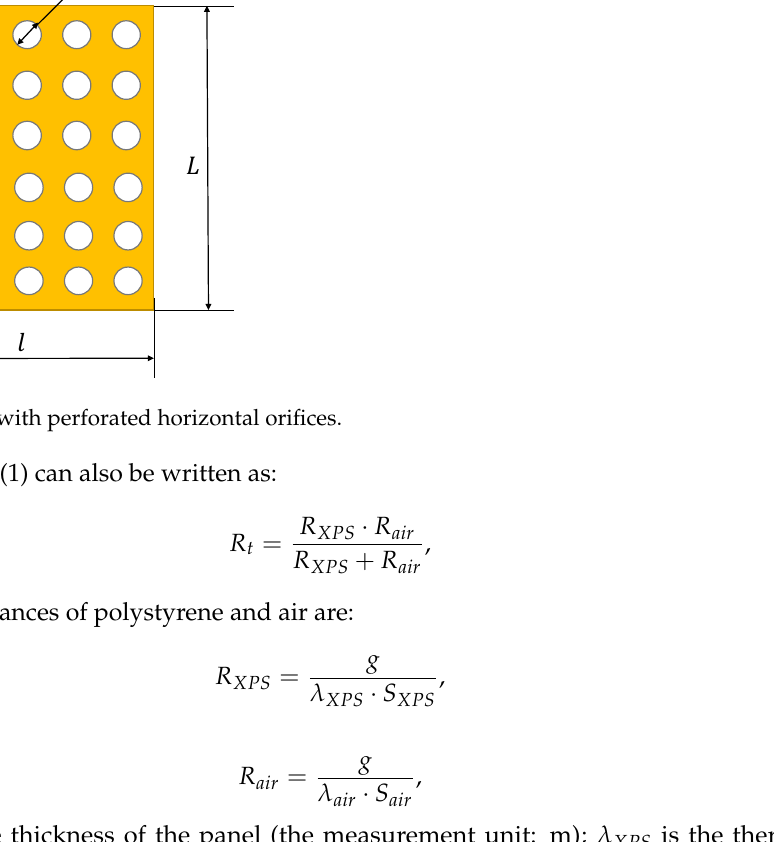
5 of 15 Table 1. The physical features of panels. Code of Panel